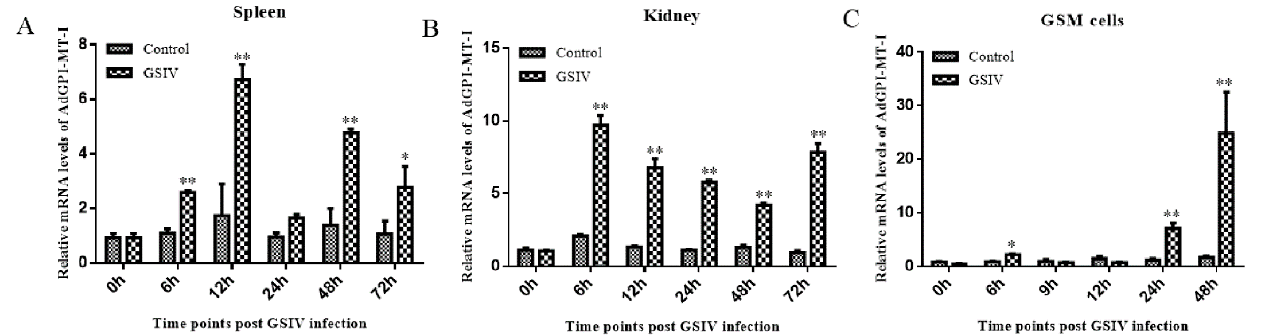
Figure 5. Expressions of AdGPI-MT-I in the spleen ( A ), kidney ( B ), and GSM cells ( C ) at indicated times post GSIV infection. The mRNA expression level of AdGPI-MT-I was determined by quantitative real-time PCR (qRT-PCR), with six salamanders included in each time period. For the convenience of comparison, the expression level in the control at 0 h normalized to β -actin was set as 1. Error bars indicate the mean ± SD ( n = 3). ** p < 0.01, * p < 0.05. Six salamanders were included in each time